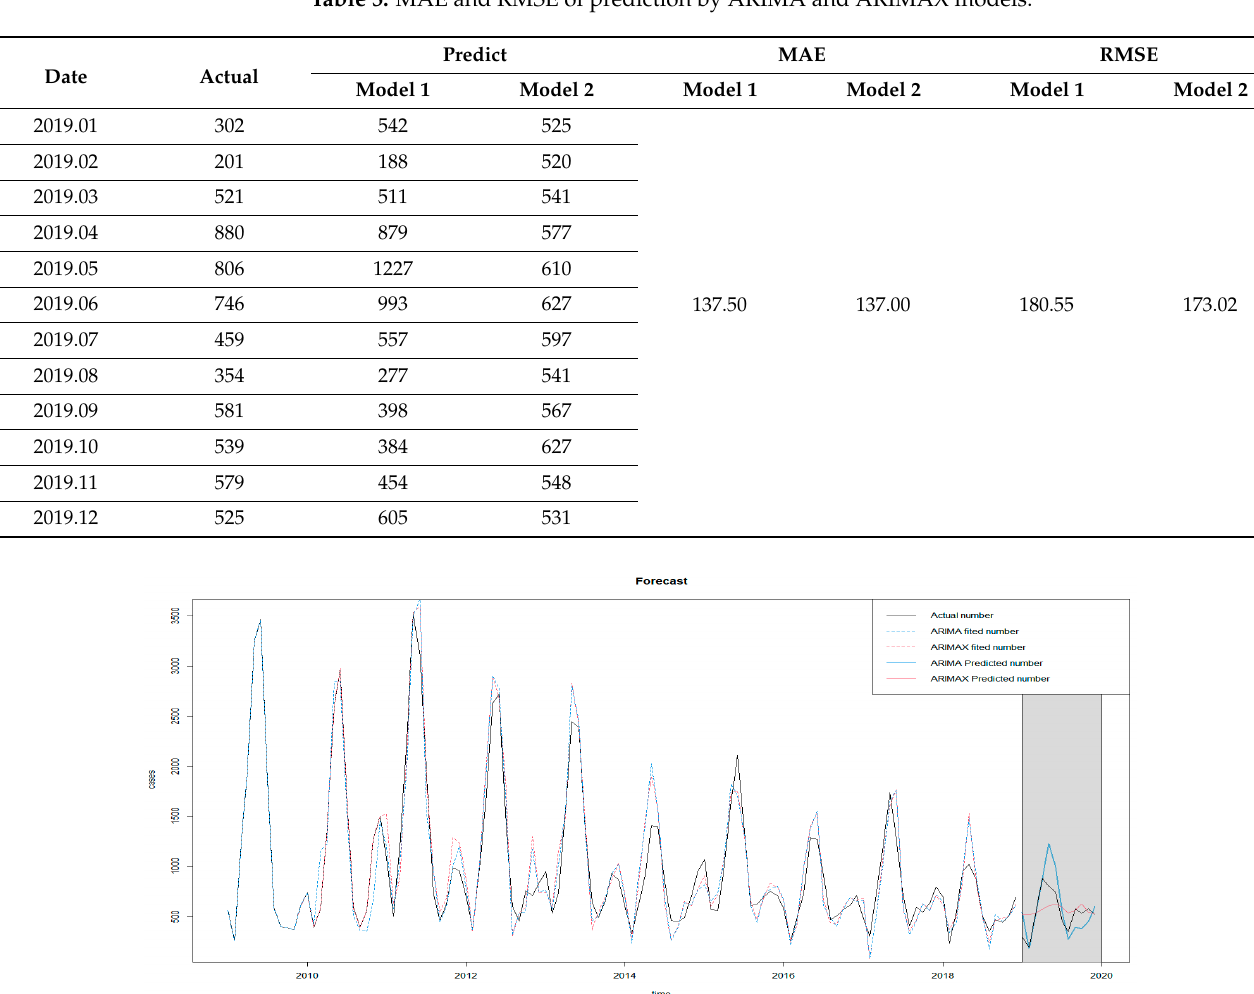
Table 5. MAE and RMSE of prediction by ARIMA and ARIMAX models.